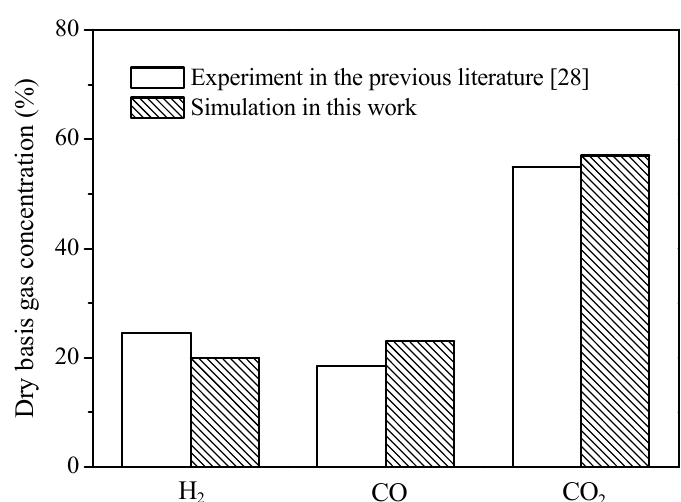
Figure 3. Comparison of dry basis gas concentrations at the fuel reactor outlet between the experiment and simulation.